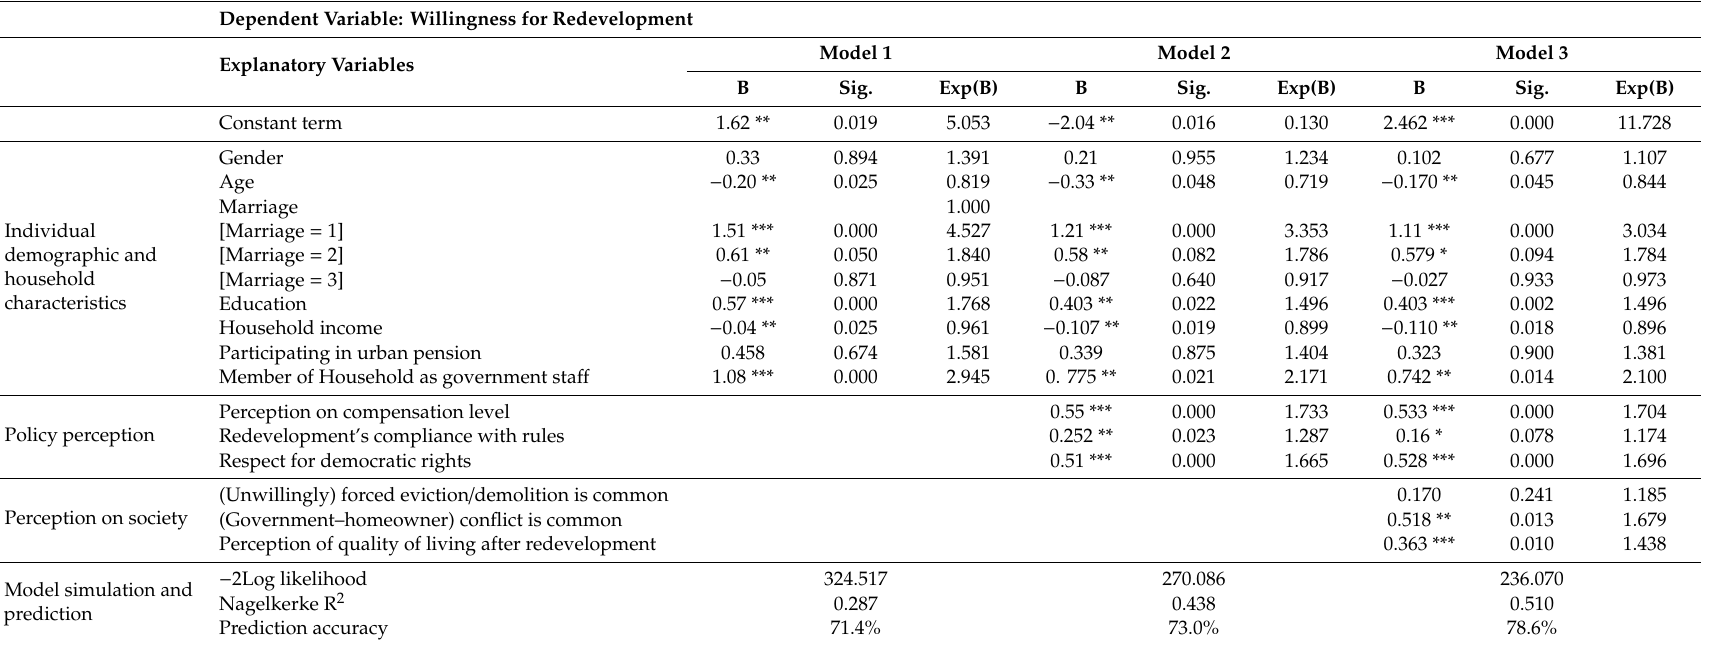
Table 7. Factors Influencing Willingness for